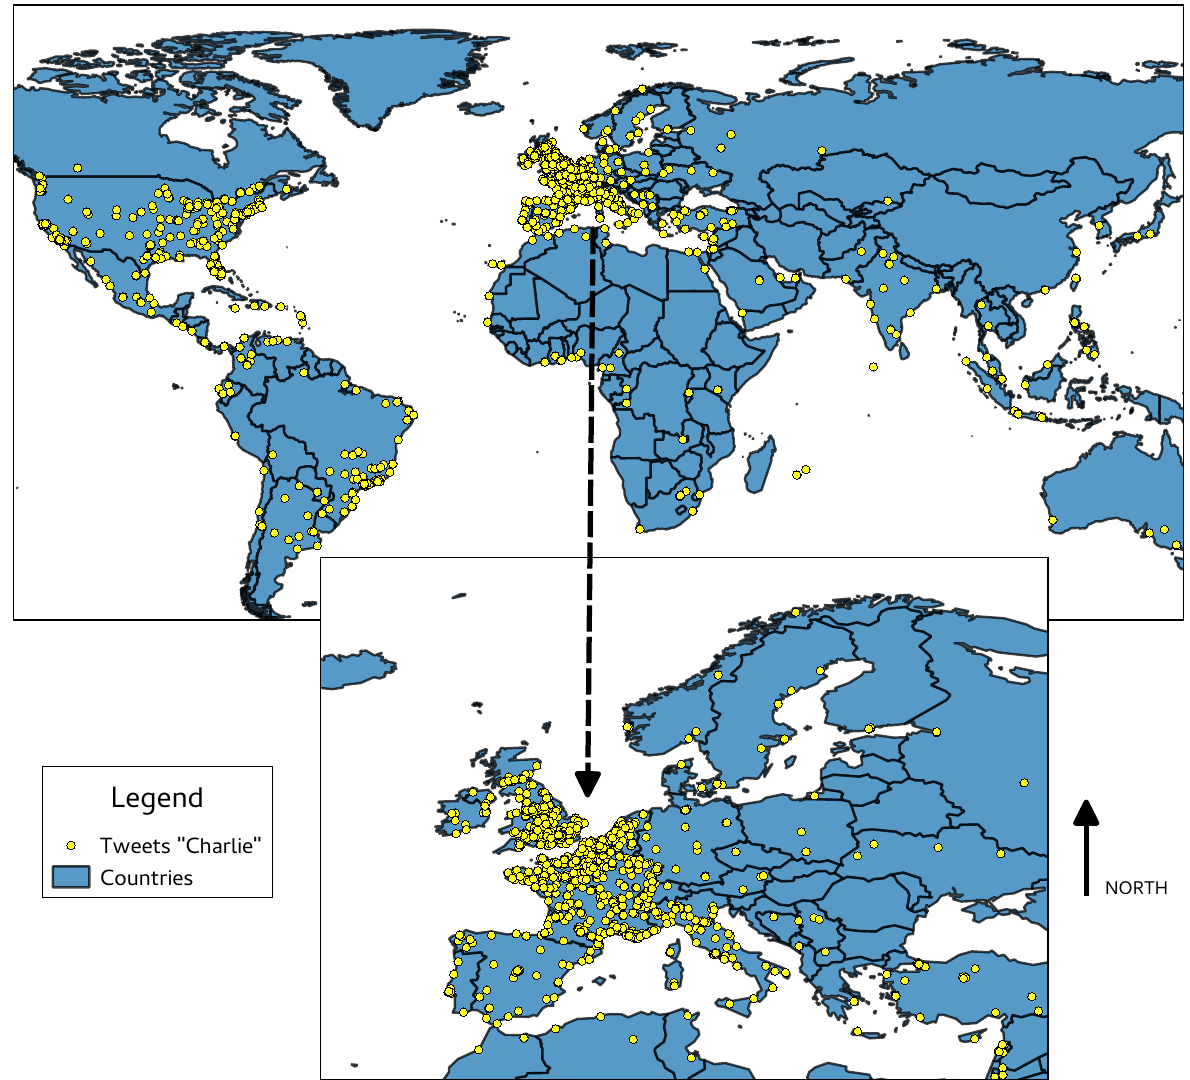
Figure 4: Locations of the tweets about the event ”Je Suis Charlie” (January, 7-14,